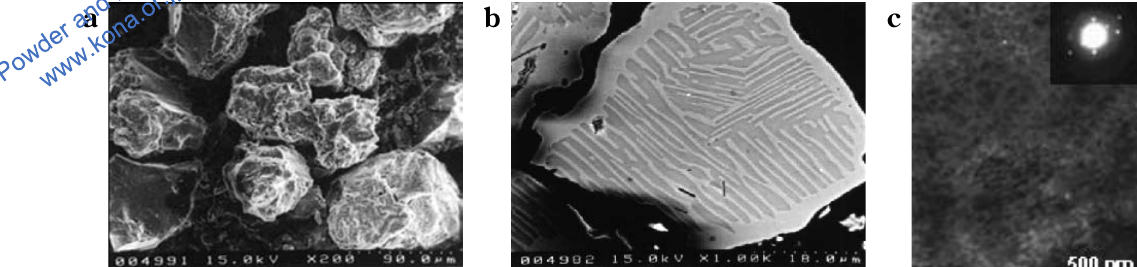
Fig.3 Morphology (a), cross-section (b) and TEM micrograph (c) of FeAl-Fe x Al y powder.